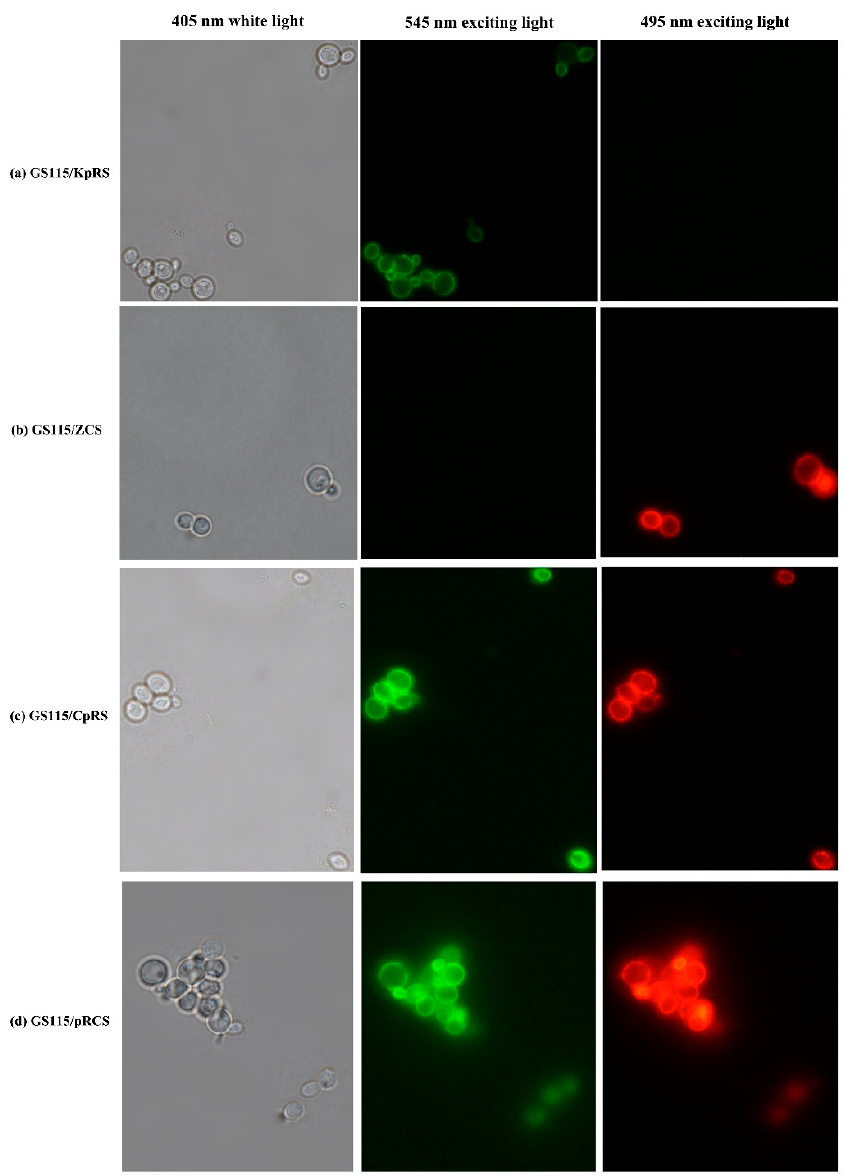
Figure 1. Fluorescence microscopy of recombinant strains displaying Rhizopus oryzae lipase (ROL) and Candida rugosa lipase 1 (CRL1). ( a , c , d ) Pichia pastoris GS115 recombinant cells displayed ROL localized to the cell surfaces with clear green fluorescence at 545 nm excitation. All cells were immunologically incubated with anti-Flag primary antibody and FITC-conjugated anti-IgG secondary antibody. ( b , c , d ) GS115 recombinants displayed CRL1 localized to the cell surfaces with clear red fluorescence at 495 nm excitation. All cells were incubated with primary anti-HA antibody and Alexa Fluor 555-labeled donkey antimouse immunoglobulin G IgG (H+L) secondary antibody. No fluorescence was detected in the control GS115 cells harboring pPICZ α or pPIC9K.